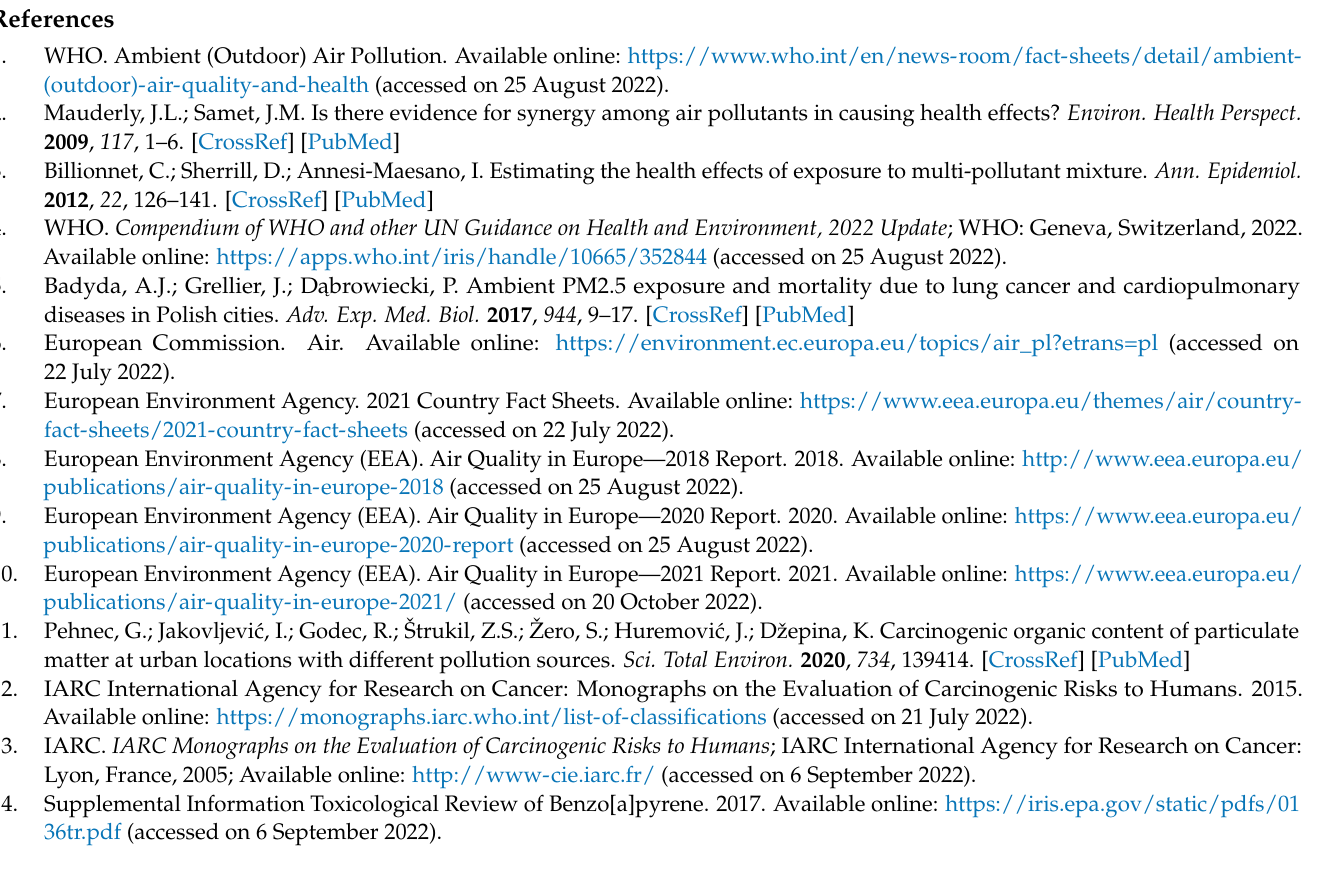
Table S3. Number of days exceeding the values of the daily mean concentrations of PM10 in the heating season and during the year. Table S4. Number of days exceeding the values of the daily mean concentrations of PM2.5 in the heating season and during the year acc. to the WHO